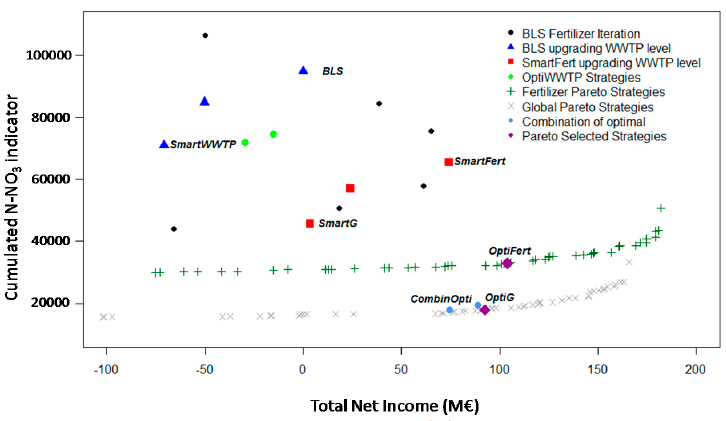
Figure 7. Pareto front strategies for the multi ‐ objective fertilization rate (291 HRU) problem (green+), and